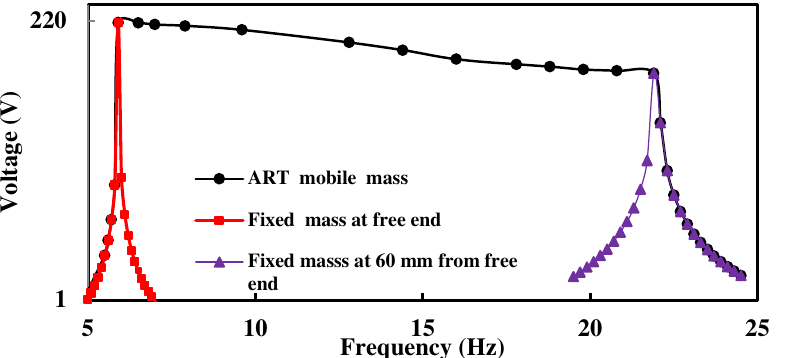
Figure 15. The resonance frequency tuning range of ART energy harvester compared with the fixed proof masses.